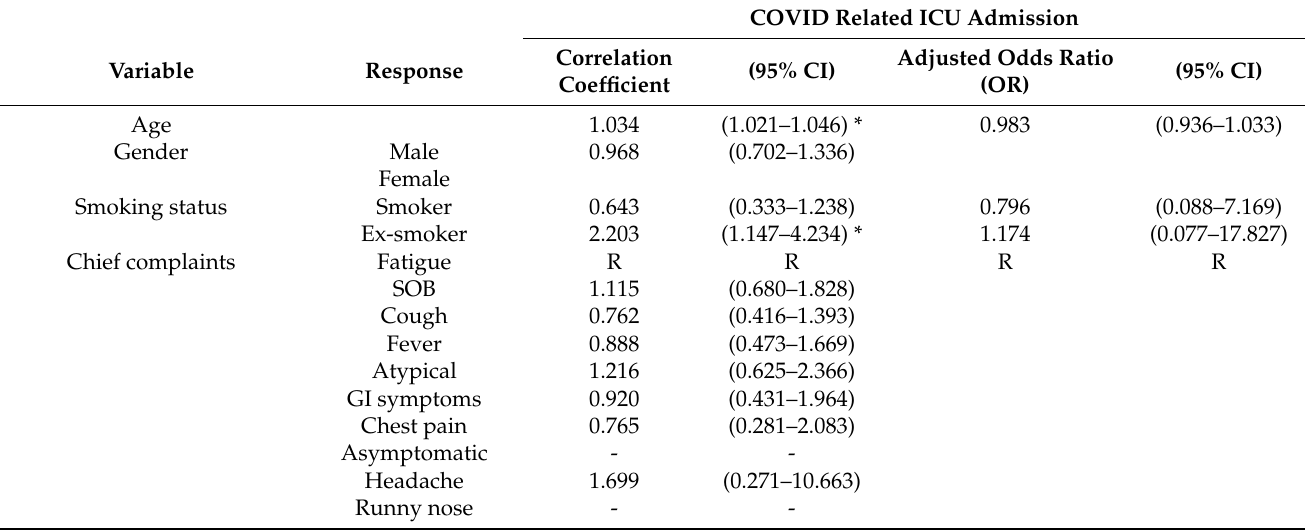
Table 5. Regression Analysis of Predictors of ICU Admission due to COVID-19 ( n =